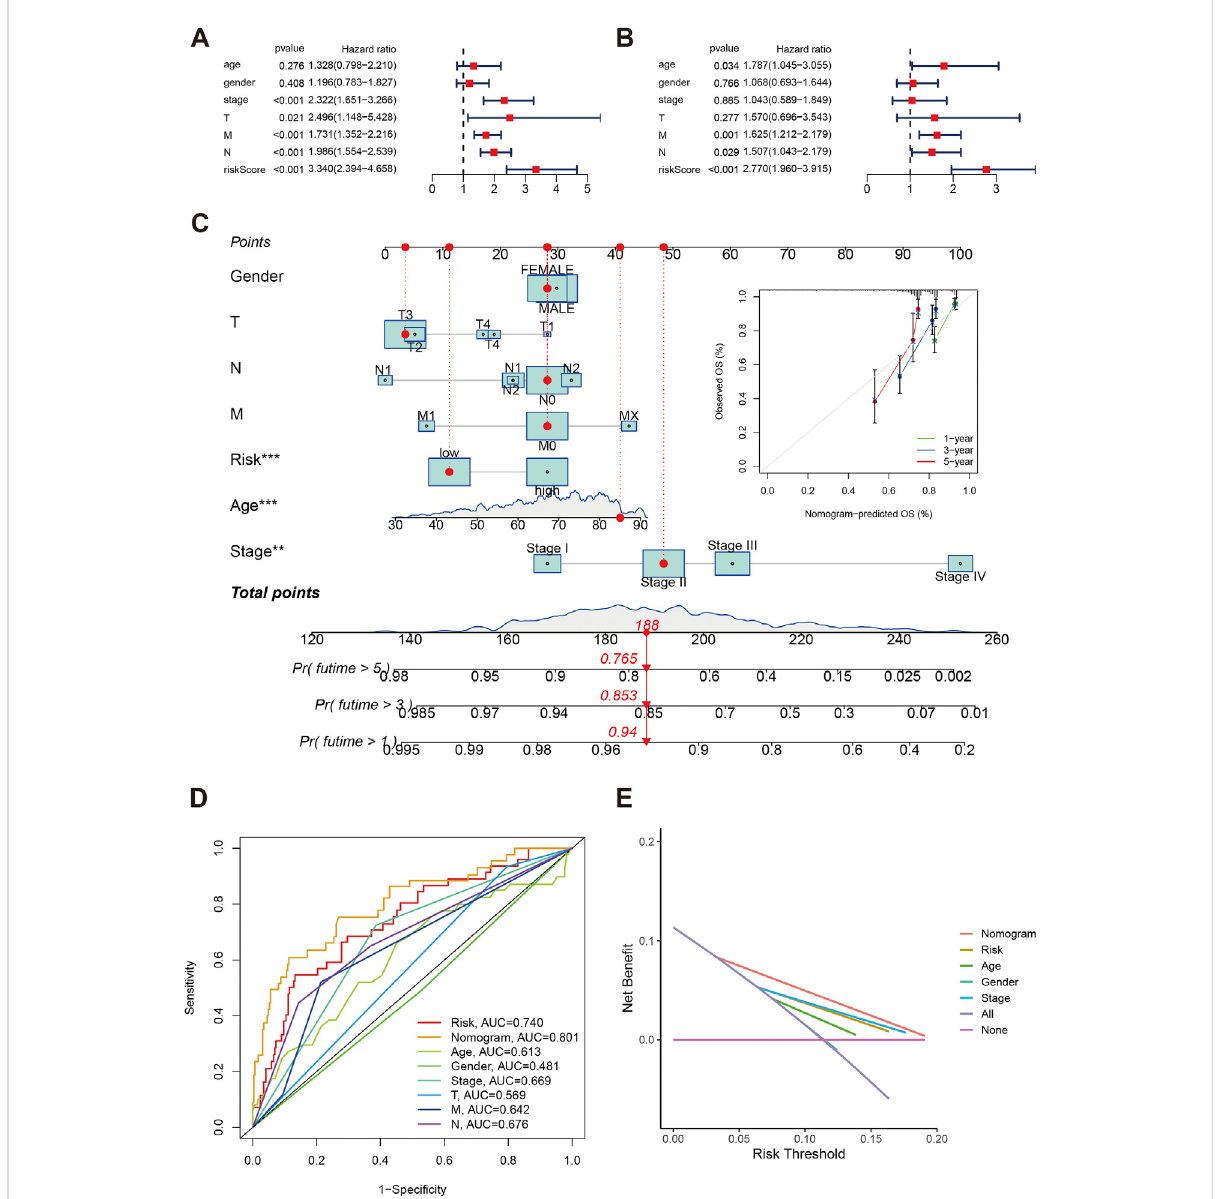
FIGURE 7 Independent analysis of risk score in COAD. (A,B) Forest plot of univariate and multivariate cox regression. (C) Nomogram and calibration plots using risk score and clinical characteristics. (D) Time-independent ROC ofnomogram, risk score and clinical parameters. (E) Decision curveshowed the clinical